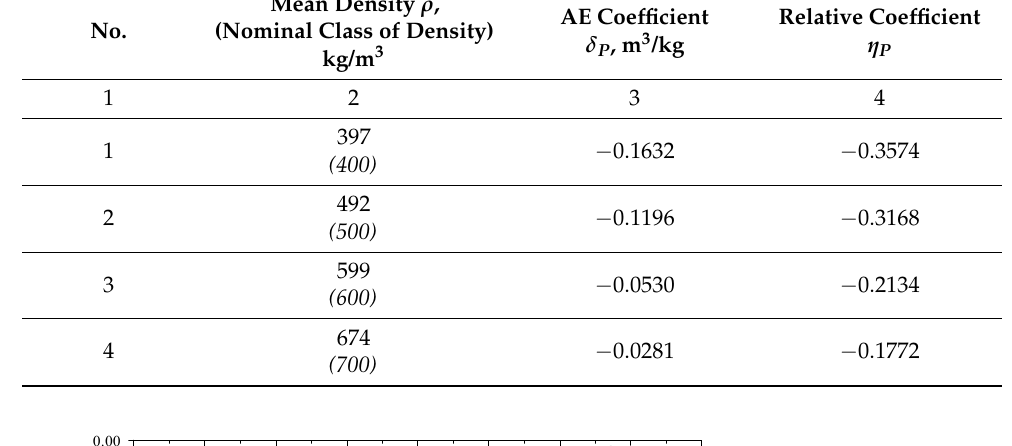
Table 3. Values of AE coefficients for concrete of specific densities.